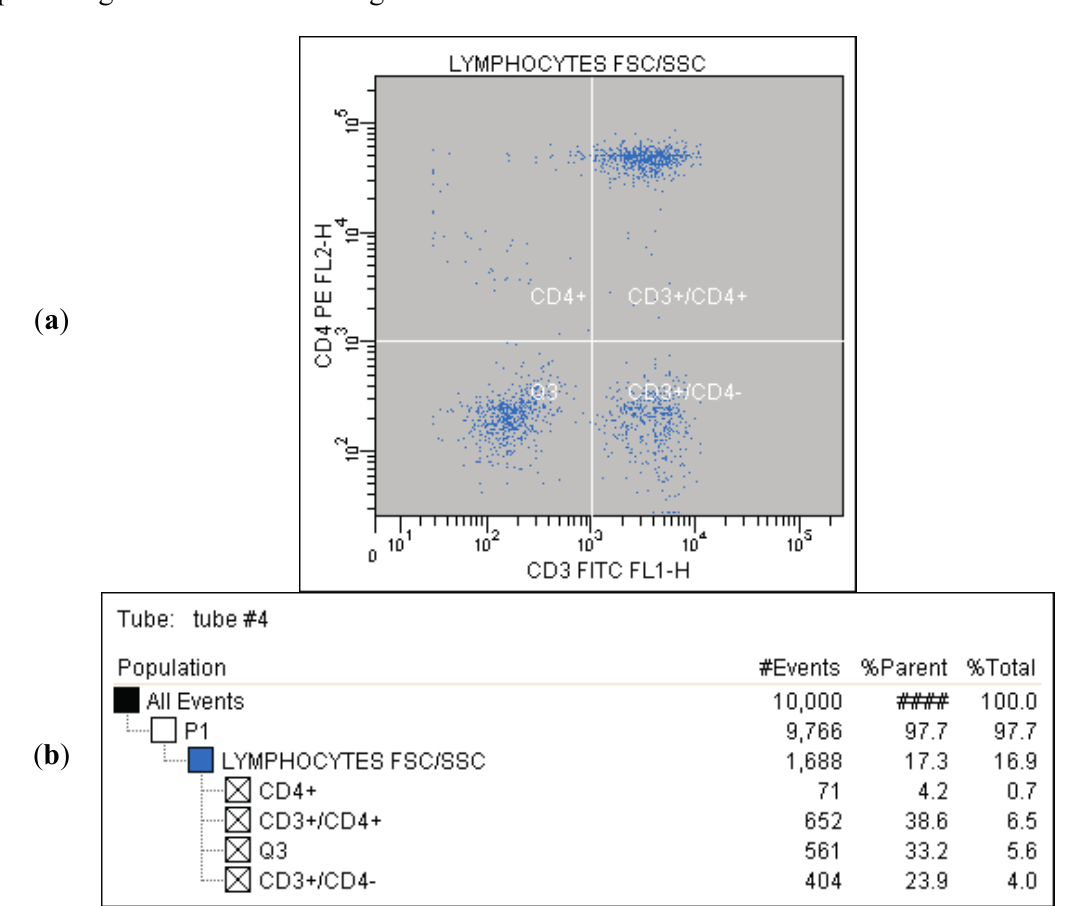
Figure 4. ( a ) Tube No. 3; Dot plot of CD3 FITC/CD8 PE with quadrant markers, differentiating lymphocytes T cytotoxic (CD3 + /CD8 + ) from all lymphocytes; ( b ) Tube No. 3; Gating tree showing gating strategy for FACS analysis as well as parent and total cell percentages within each of the gates for CD8 + and CD3 + .